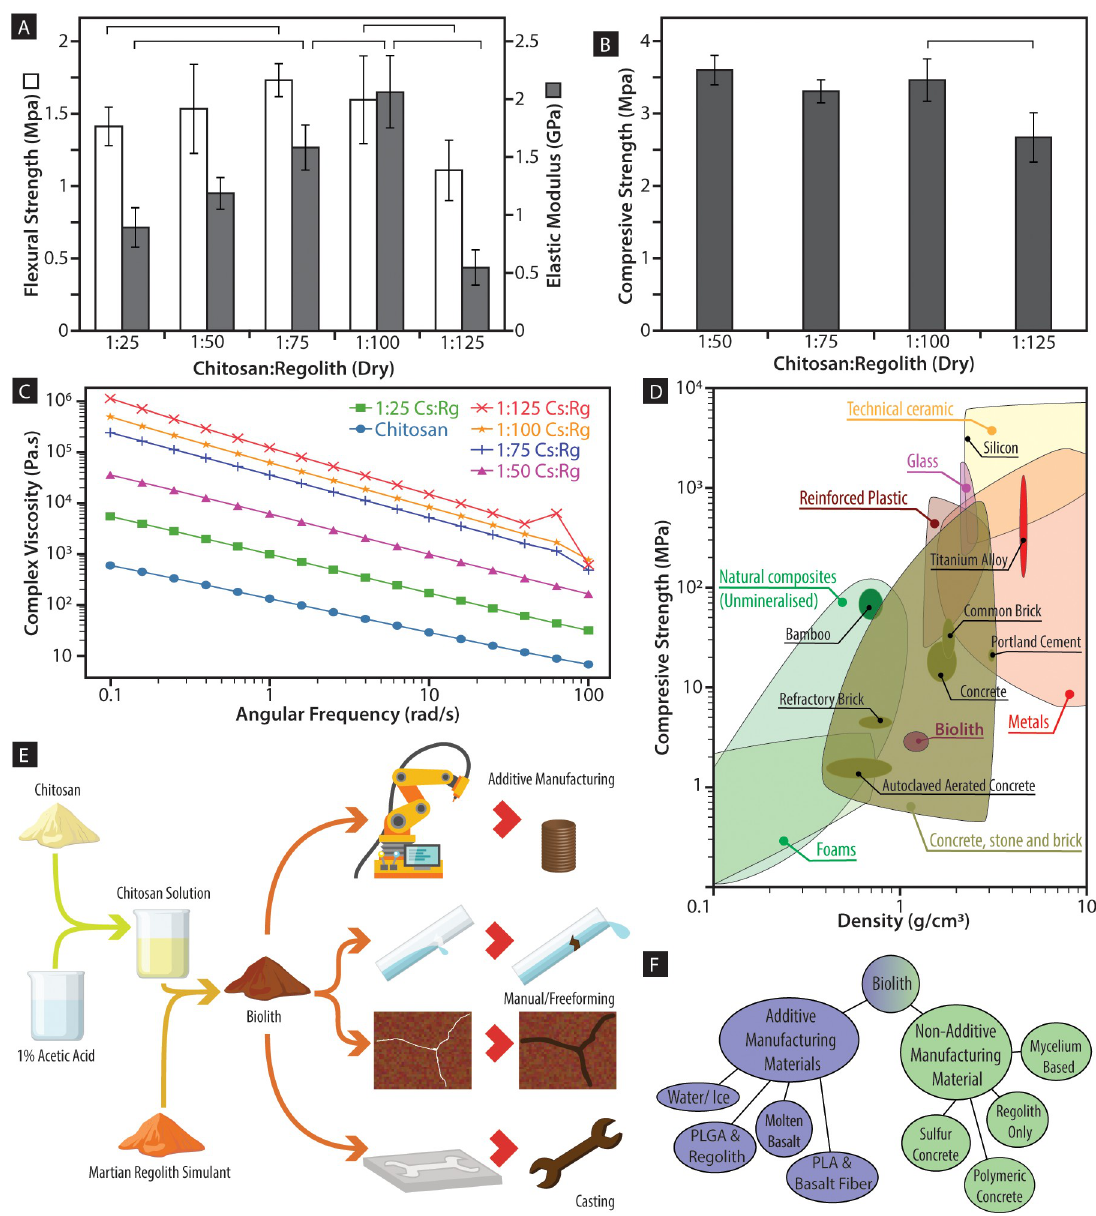
Fig 2. Mechanical characteristics of biolith composite. (A) Flexural strength and elastic modulus of biolith with varying chitosan to regolith ratio. There is a significant increase in flexural strength as regolith is increasingly added to a 1:75 ratio. At a 1:100 ratio, a significant decrease in flexural strength was observed. A similar relationship for elastic modulus was also observed; (B) A significant drop of compressive strength occurred beyond the 1:100 ratio; (C) Shear thinning behavior and increasing complex viscosity with added regolith was observed, likely due to the presence of chitosan; (D) Ashby plot showing dried biolith with mechanical properties similar to refractory brick; (E) Three different uses of biolith were demonstrated. From the prepolymer solution, the pliable liquid crystal-regolith mixture was cast into different geometries including a wrench that was later tested, used to repair a broken pipe, and used in additive manufacturing to produce a scaled habitat model; (F) The versatility to be shaped, printed, or casted without modification positions biolith as a unique material obtainable in a basic Martian